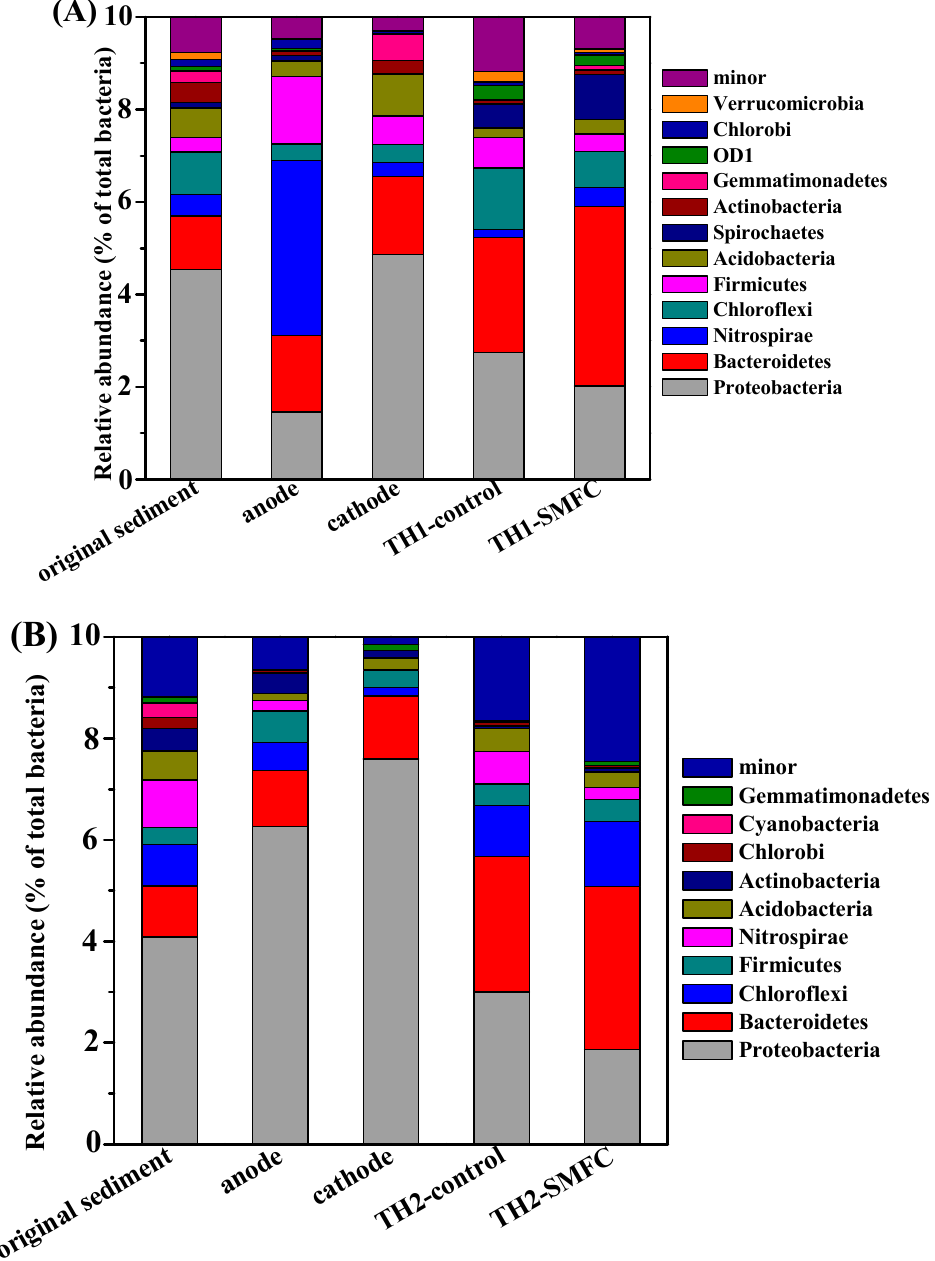
Figure 5. Relative abundances percentages of bacterial phyla ( A , B ) communities in original sediments, bulk sediments and electrode biofilm from the two sampling sites at the end of the experiments. The minor designation represents the sum of bacteria in a sample with a relative abundance < 3%.